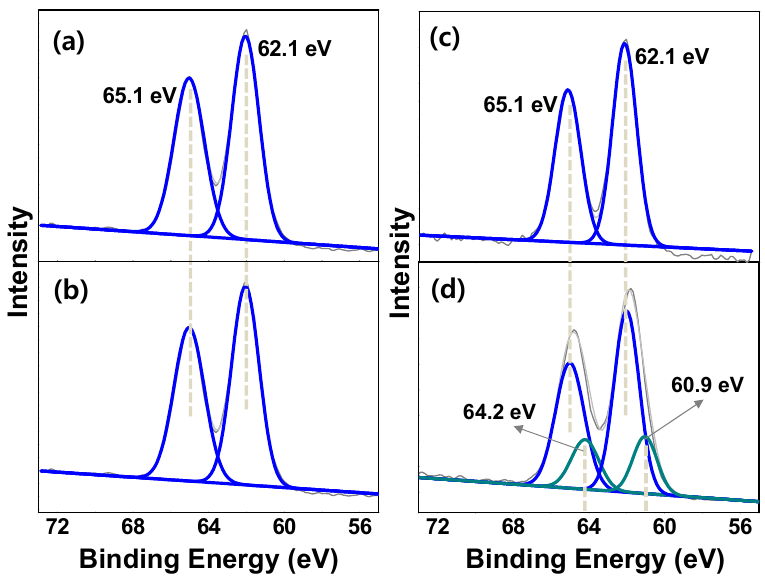
Figure 3. Ir 4f XP spectra of ( a ) Ir 1.4 @bpy-CTF400, ( b ) Ir 4.1 @bpy-CTF400, ( c ) Ir 4.7 @bpy-CTF400 and ( d ) Ir 10.6 @bpy-CTF400 (the peaks corresponding to the binding energy of Ir(III) complex is represented using blue and the peaks corresponding to the binding energy of Ir(0) species is represented using green).